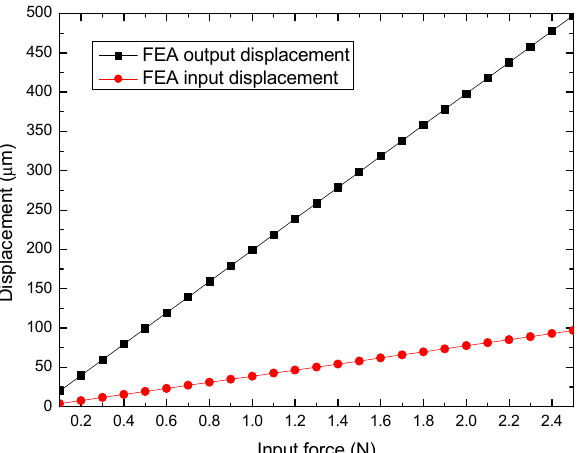
Figure 6. Input (at bridge mechanism) and output displacement (in each jaw) of the MG, under a force swept.